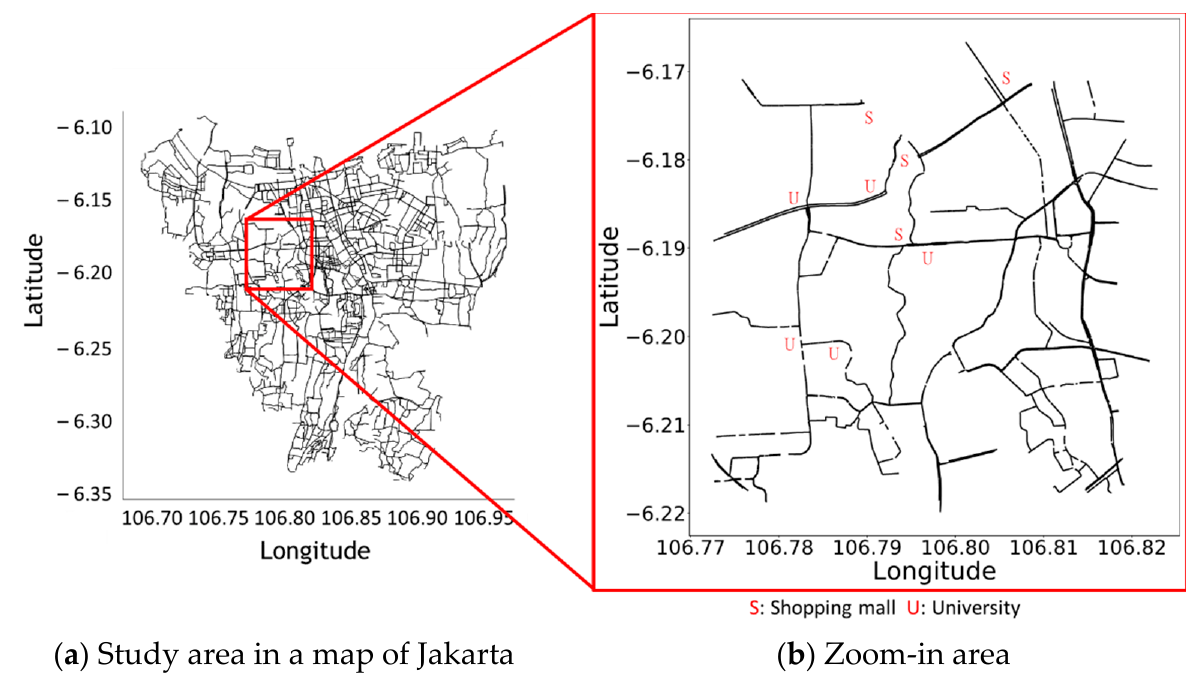
Figure 5. The case study area in west Jakarta.